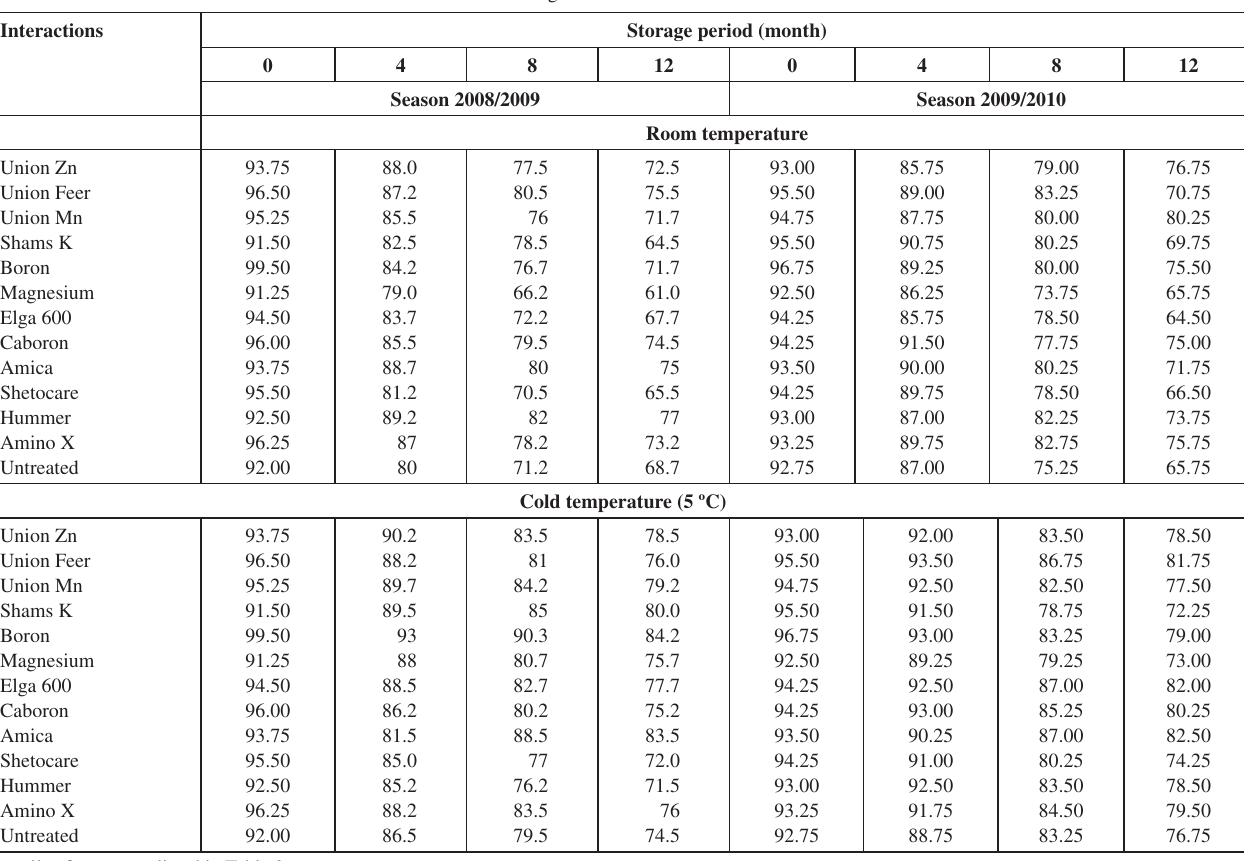
Table 10: Effect of the interaction between storage temperature, storage period and foliar application with commercial compounds on germination (%) of onion seeds during seasons of 2008/2009 and 2009/2010 Interactions